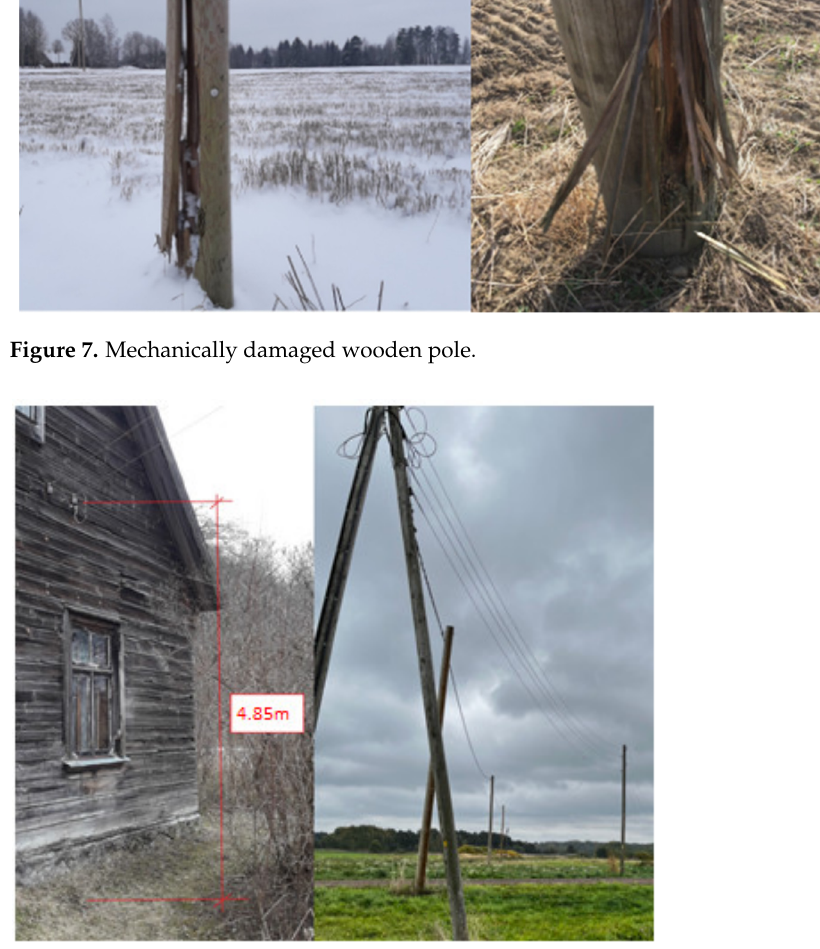
Figure 8. Incorrect distance to the ground.